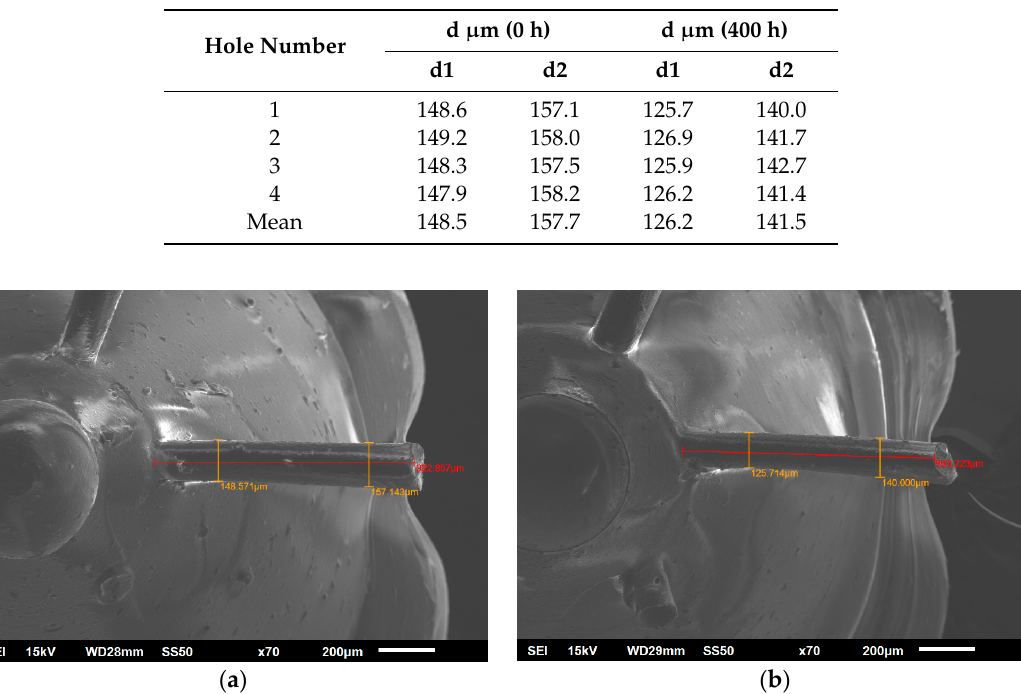
Figure 7. Micrographs of the injector holes: ( a ) nozzle before the experiment (0 h); and ( b ) nozzle after the experiment (400 h) using 50PF50D. Table 5. Dimensions measured from the injector nozzle holes before (0 h) and after (400 h) the experiment using 50PF50D.